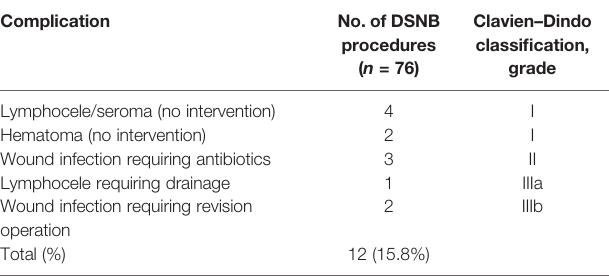
TABLE 6 | DSNB-related